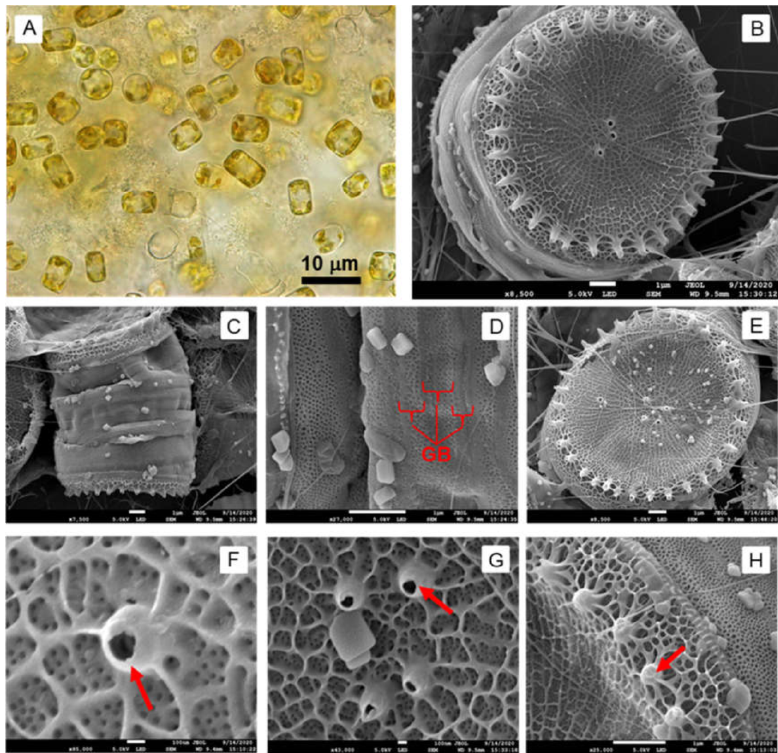
Figure 1. Morphological features of the diatom. Fluorescence microscopic image (100 × magnification; bar = 10 µ m) ( A ) and FESEM images: 8500 × magnified valve view (bar = 1 µ m) ( B ); 7500 × magnified girdle view (bar = 1 µ m) ( C ); 27,000 × magnified girdle region (girdle bands are marked as GB) (bar = 1 µ m) ( D ); 8500 × magnified valve view (bar = 1 µ m) ( E ); 85,000 × magnified valve central region (bar = 100 nm) ( F ); 43,000 × magnified valve central surface (bar = 100 nm) ( G ); 25,000 × magnified valve peripheral region (bar = 1 µ m) ( H ). Rimoportulae (marked by red arrows) are the protruding tube-like structures located in the central region and the periphery of the valves ( B , E – H ).